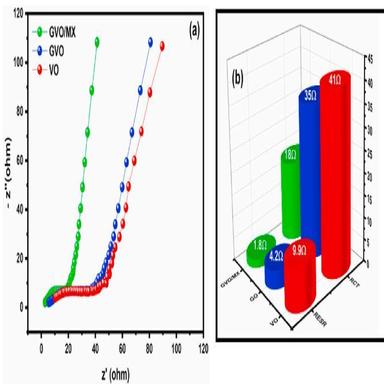
(a) Nyquist plots for VO, GVO and GVO/MX, (b) Comparative RESR and RCT values for VO, GVO and GVO/MX.